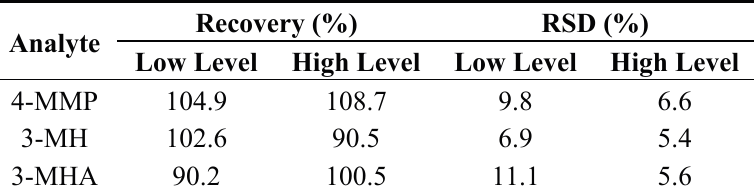
Table 2. Recovery and precision